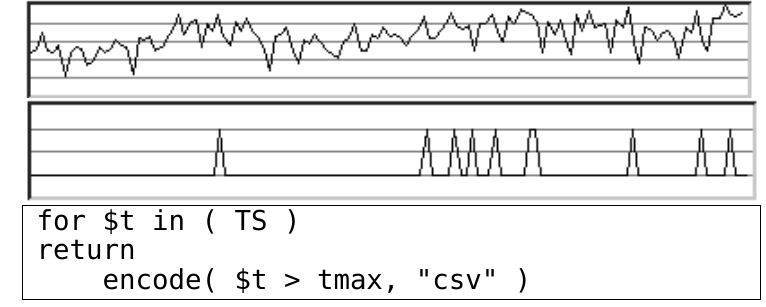
Figure 2. Sample time series (top) and threshold indicator array